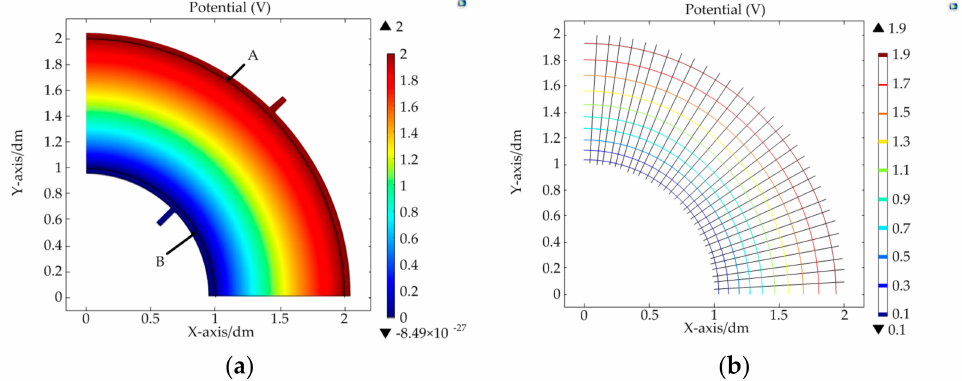
Figure 9. Simulation results of the upper conductive layer: ( a ) distribution map of the electric potential; ( b ) diagram of the electric field line and equipotential